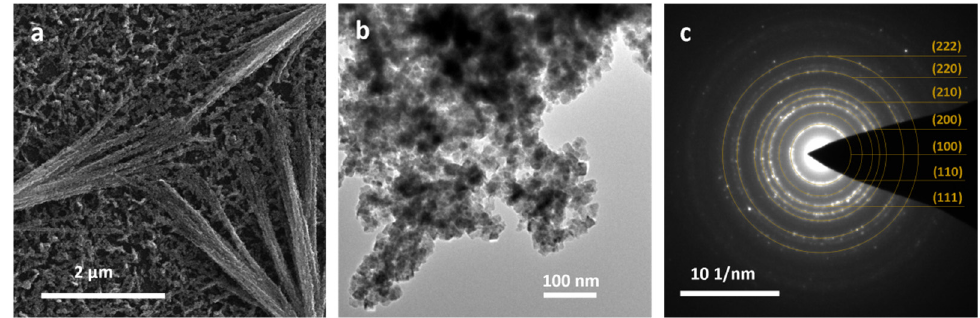
Figure 8. Cu 3 N nanocrystals: ( a ) SEM image, ( b ) TEM image, ( c ) SAED pattern. SAED pattern with characteristic rings of (111), (110), (100), (200), (210), (220) and (222) planes confirmed formation of the copper nitride (Figure 8c). XRD pattern exhibits reflection with a small intensity—a characteristic of Cu 3 N at the 23.52° 2 ϴ value—but the result was not confirmed due to the presence of residual reflections from silica substrate.